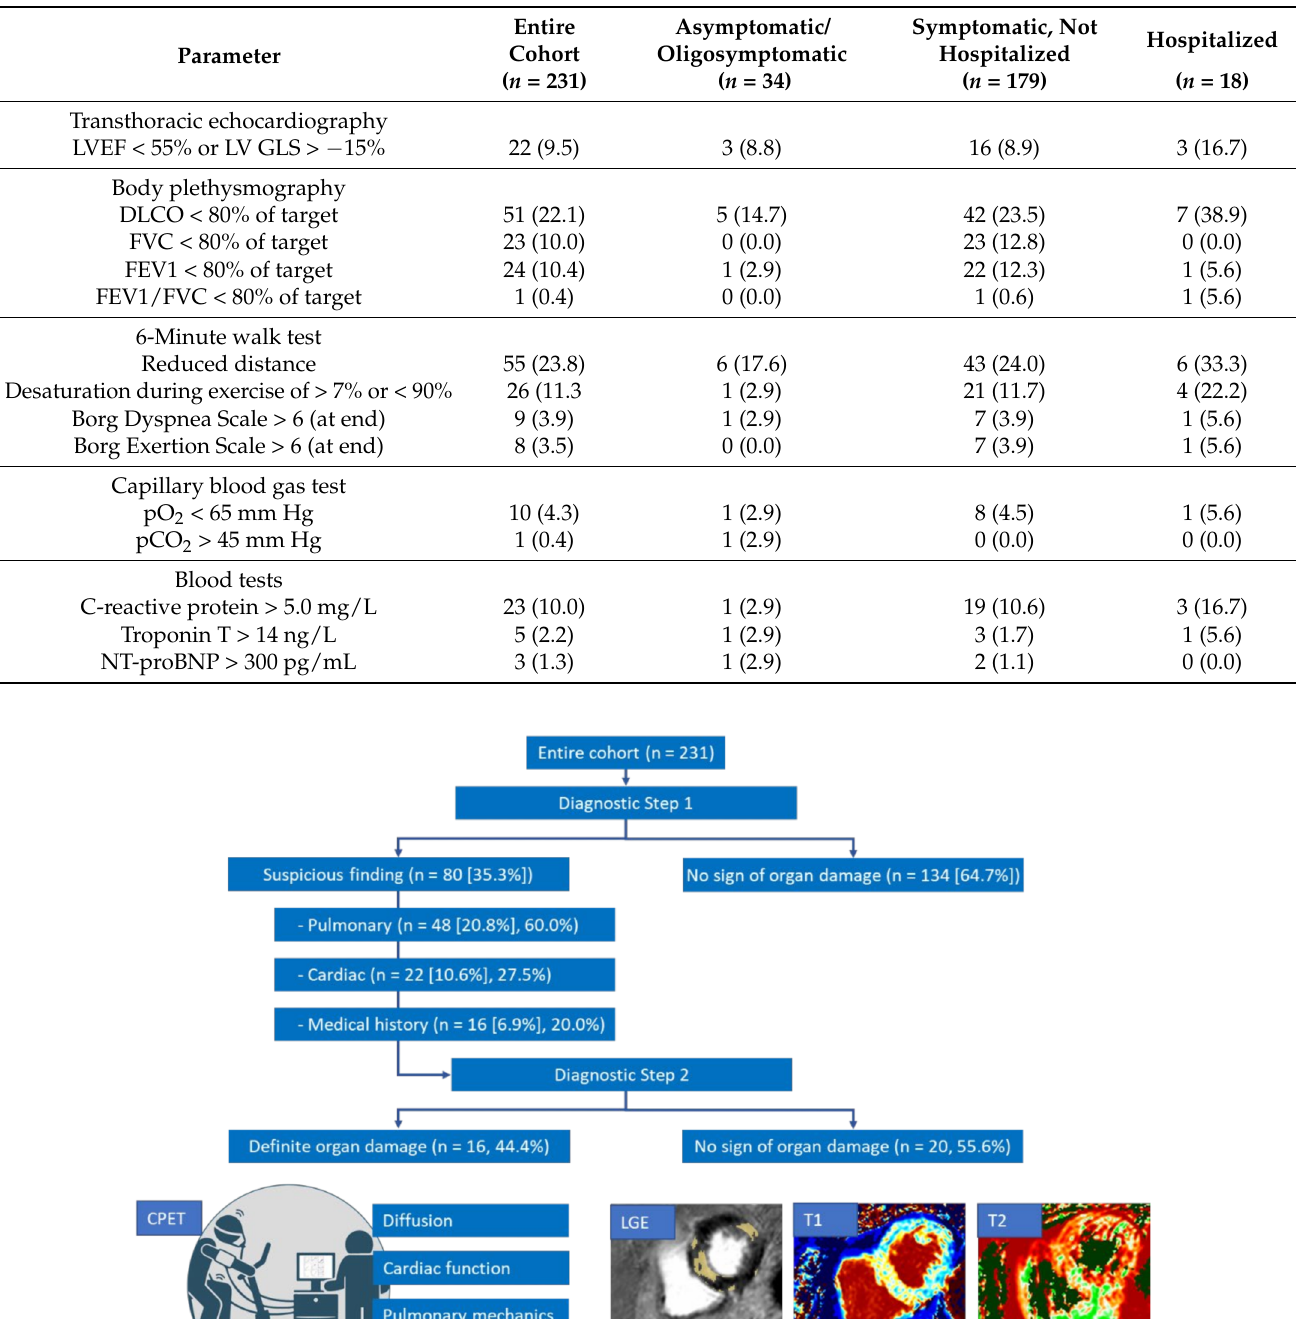
Table 2. Decisive findings in Step 1 of the proposed diagnostic approach.